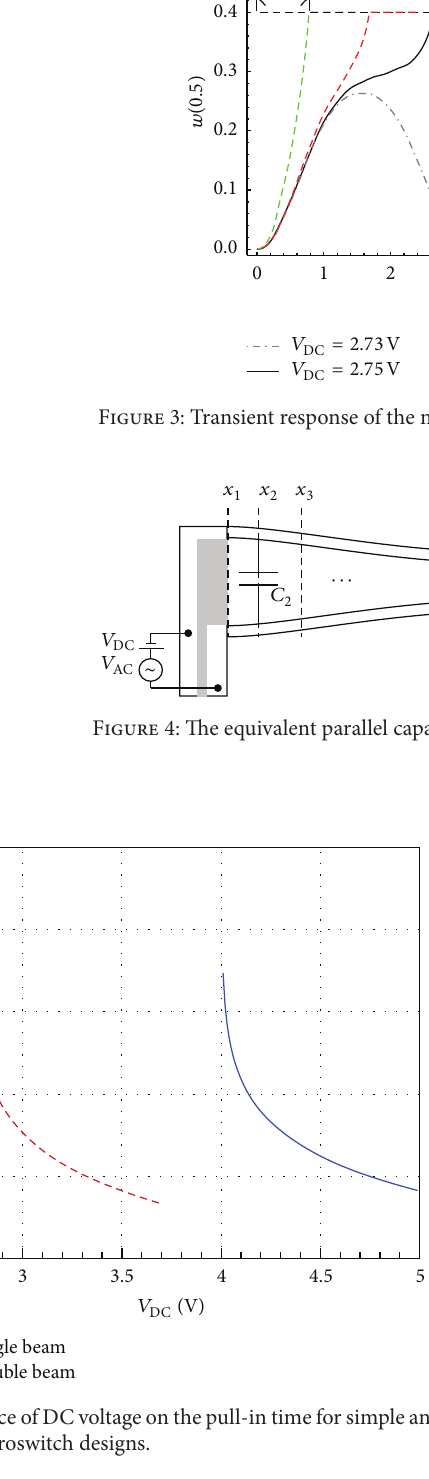
two other sides of the box. The wave ports are the boundary condition that permits energy to flow into and from the microswitch’s